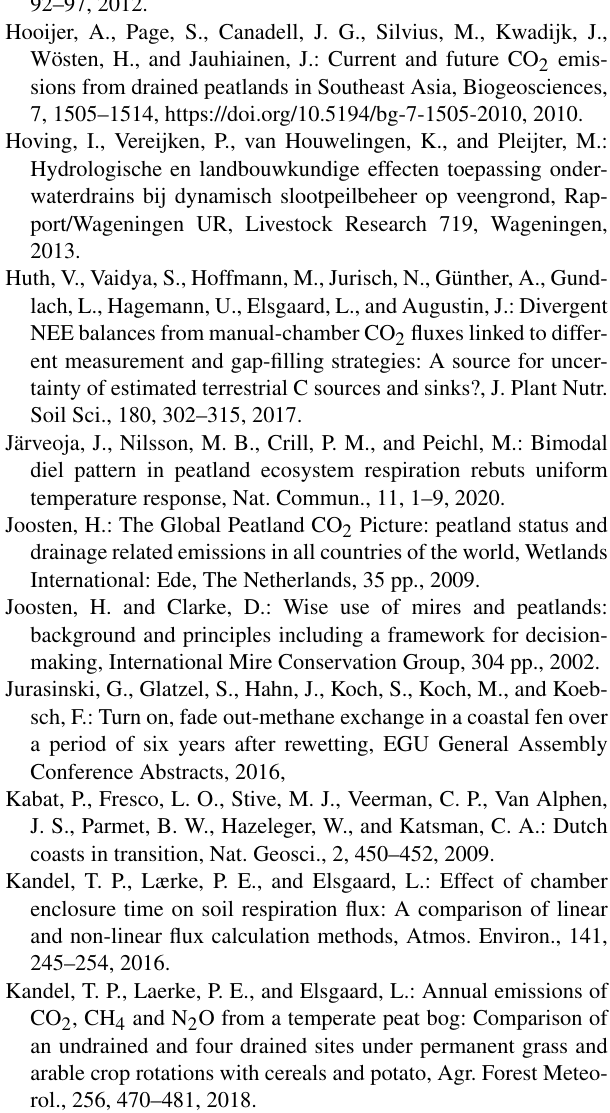
table position on carbon dioxide and methane emissions